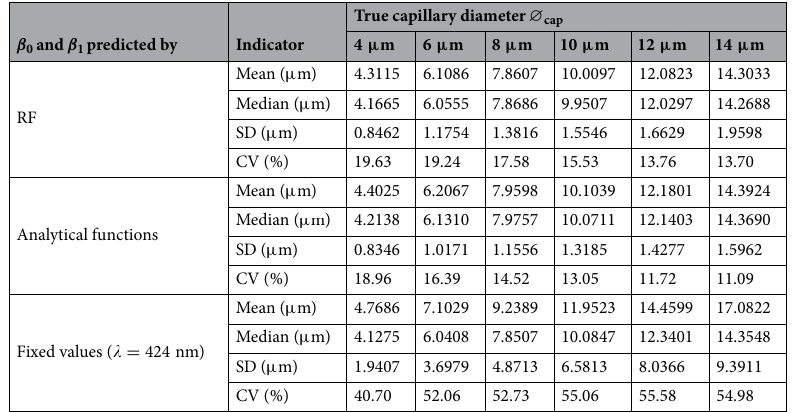
β 0 and β 1 predicted by Indicator